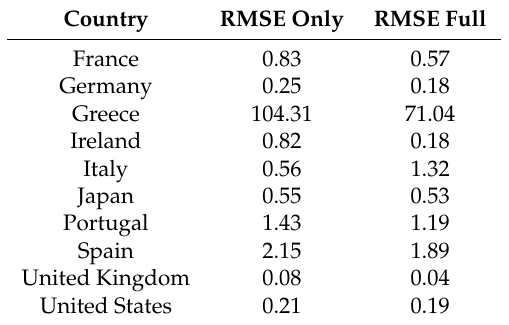
Table 5. August 2012: comparison between the root mean square errors (RMSE) obtained with our full structural VAR model (RMSE full) and with a model composed by the solely autoregressive component (RMSE only autoregressive). Country RMSE Only RMSE Full France 0.83 0.57 Germany 0.25